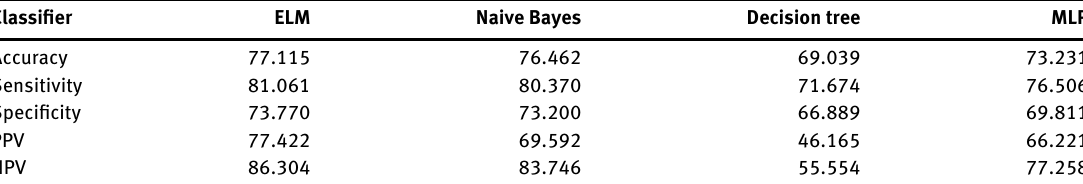
Table 4: Comparison Results.